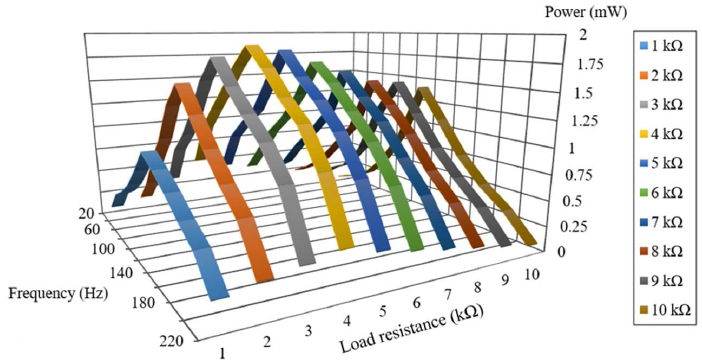
Figure 2. Output power at varying load resistances.